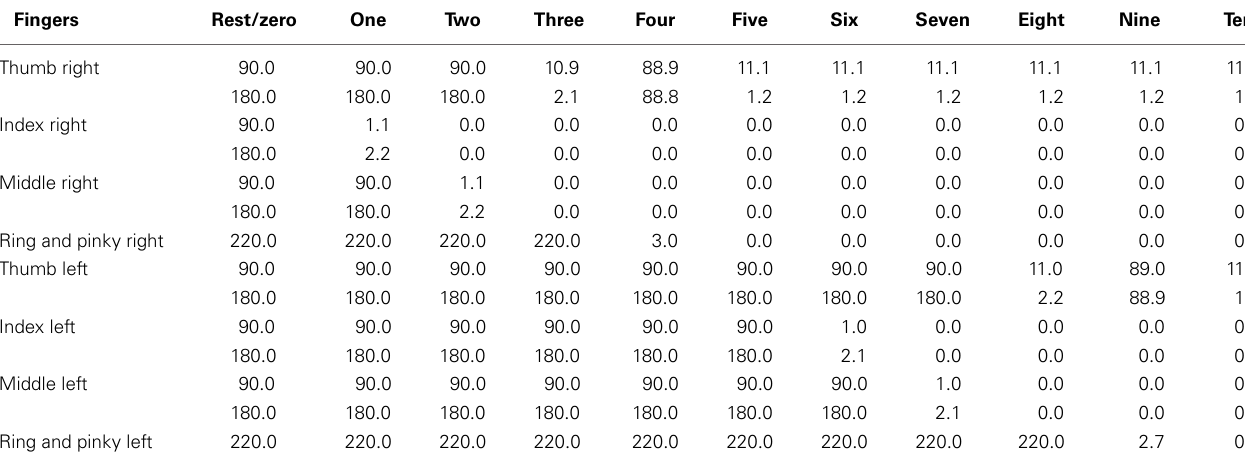
Table 1 | Actual finger joint positions according to number representation.